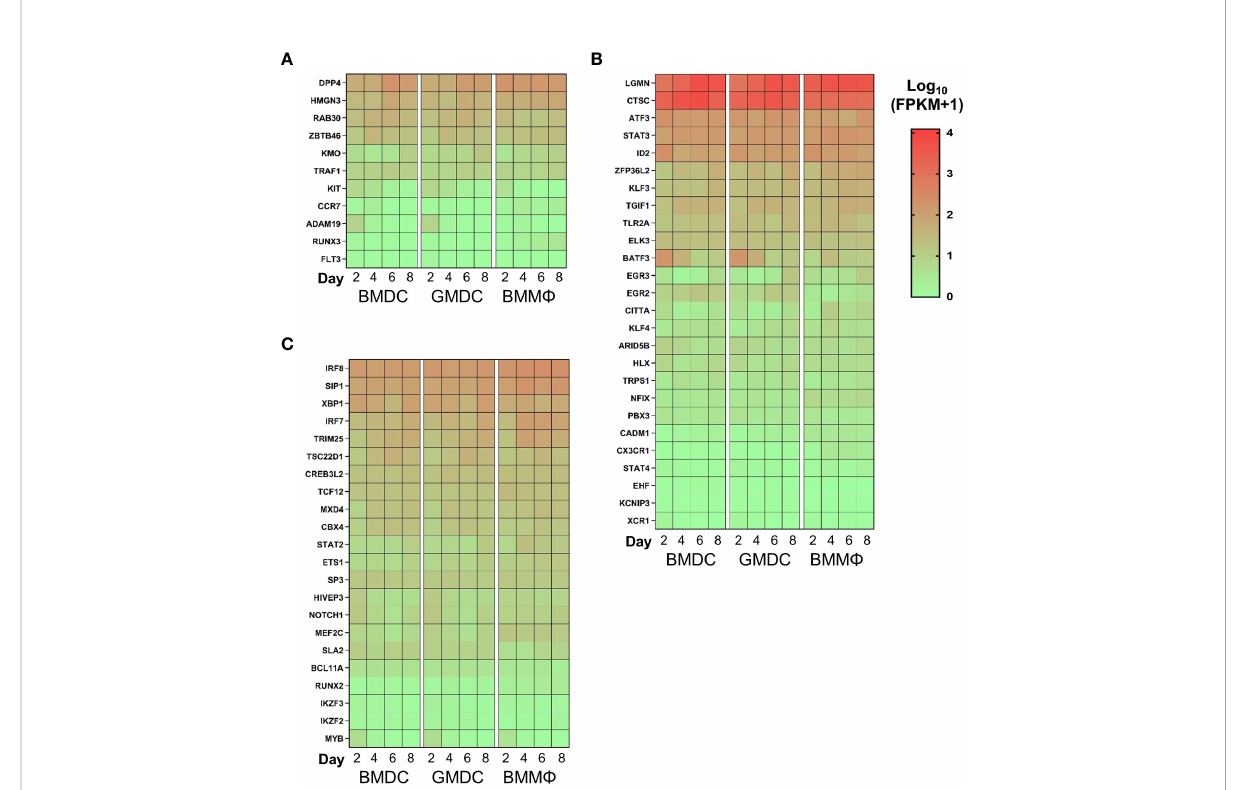
FIGURE 8 Chicken BM cultures are not enriched for DC related transcripts. Heat maps of gene expression levels of (A) pDC; (B) cDC and (C) core DC markers. Heat maps are represented as the median of Log10 transformed Fragments Per Kilobase of transcript per Million mapped reads (FPKM) values from three independent biological replicates on each day from each culture. High reads shown in red and low reads in